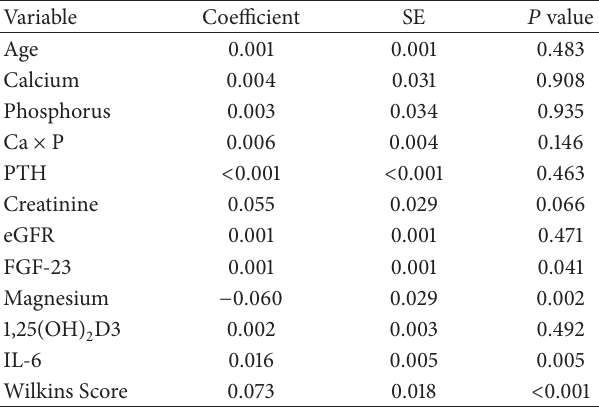
Table 4: Multivariate linear regression analysis of influencing factors of